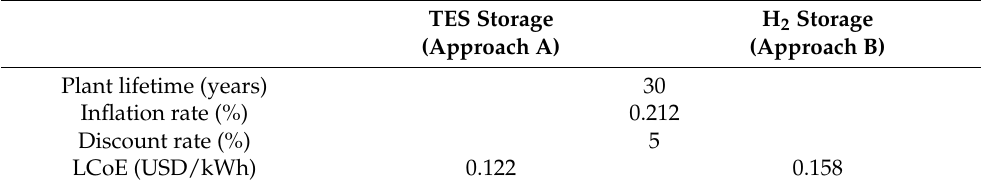
Table 7. Levelized cost of electricity (LCoE) for both energy storage